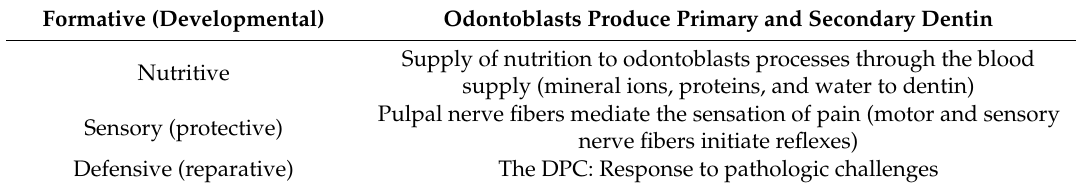
Table 1. Key functions of dentin–pulp complex